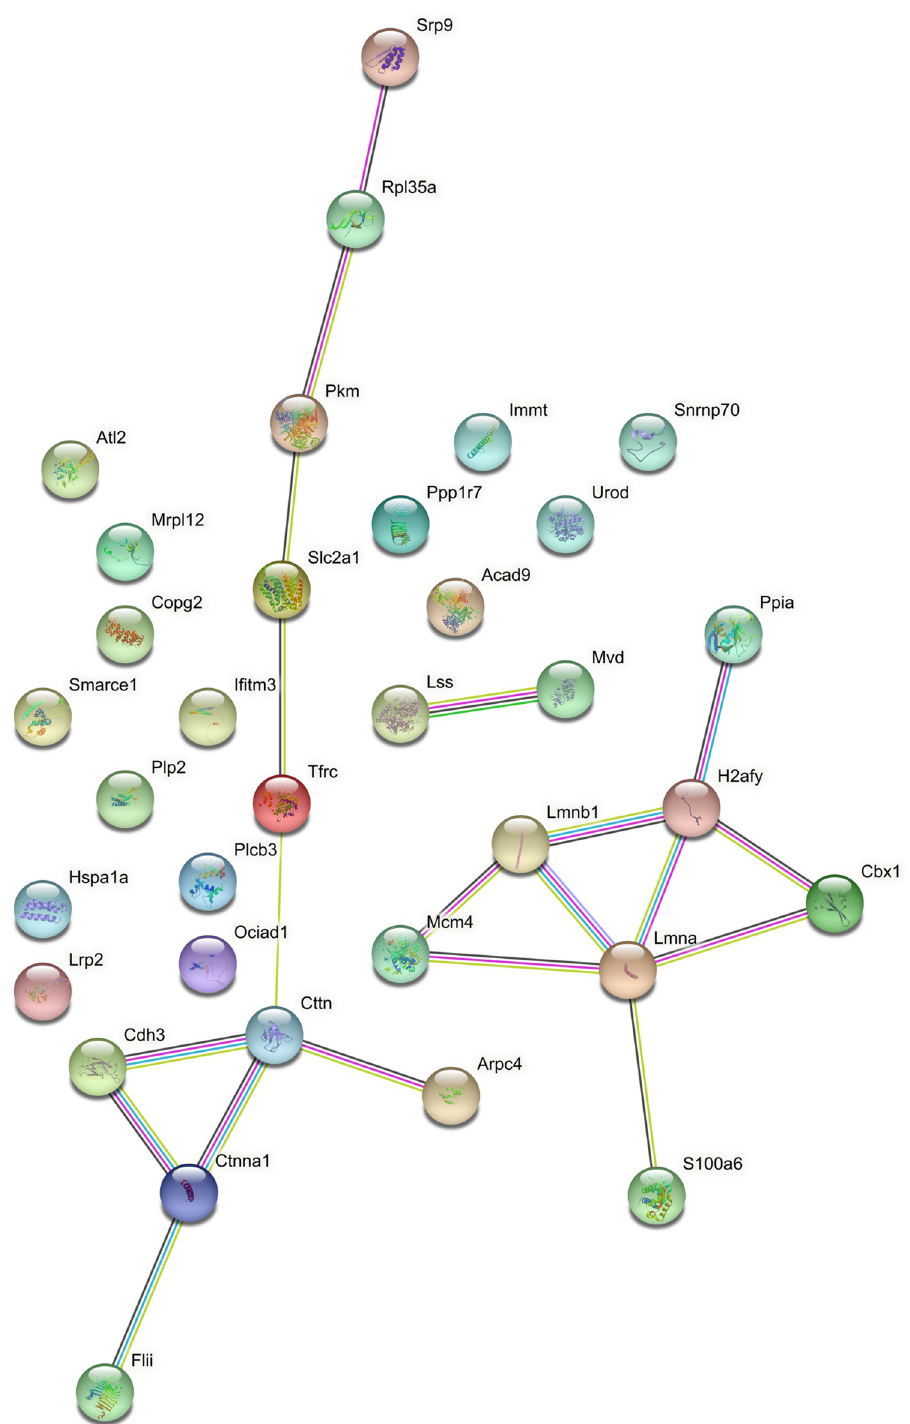
Fig 8. Interaction plot (STRING) showing protein-protein relations within the set of up-regulated MPSIEC proteins. Edges between network nodes represent protein-protein associations, which are classified as “known interaction” (light blue: from curated databases; purple: experimentally determined), “predicted interactions” (green: gene neighbourhood; red: gene fusions; blue: gene co-occurrence) or “others” (yellow: textmining; black: co- expression; pale blue: protein homology) (https://version-11-5.string-db.org/cgi/network?networkId= blUqyaKyKA9R).